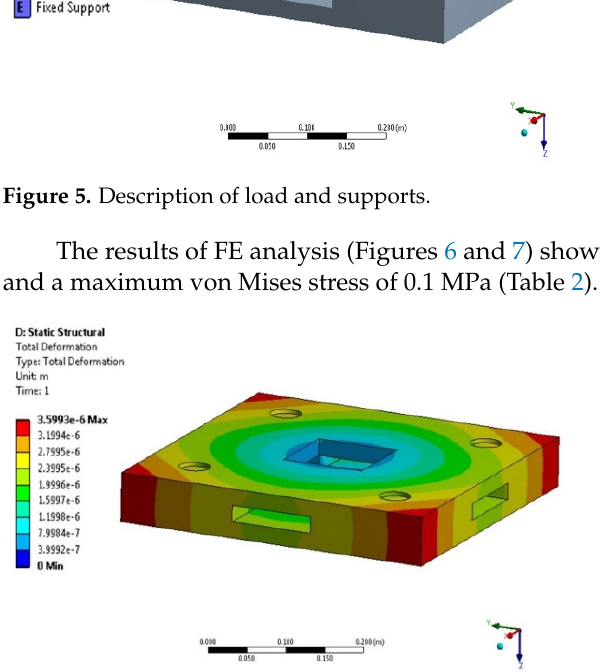
Figure 7. Von-Mises stress for initial geometry. Table 2. Equivalent stress and maximum deformation for monocoque model. Equivalent Stress (MPa)